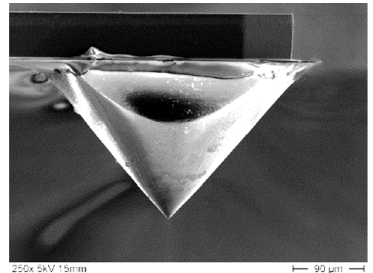
Figure 29. Piezo-resistive microprobe with a spherical 2 µm radius diamond tip glued onto the free end of the cantilever.